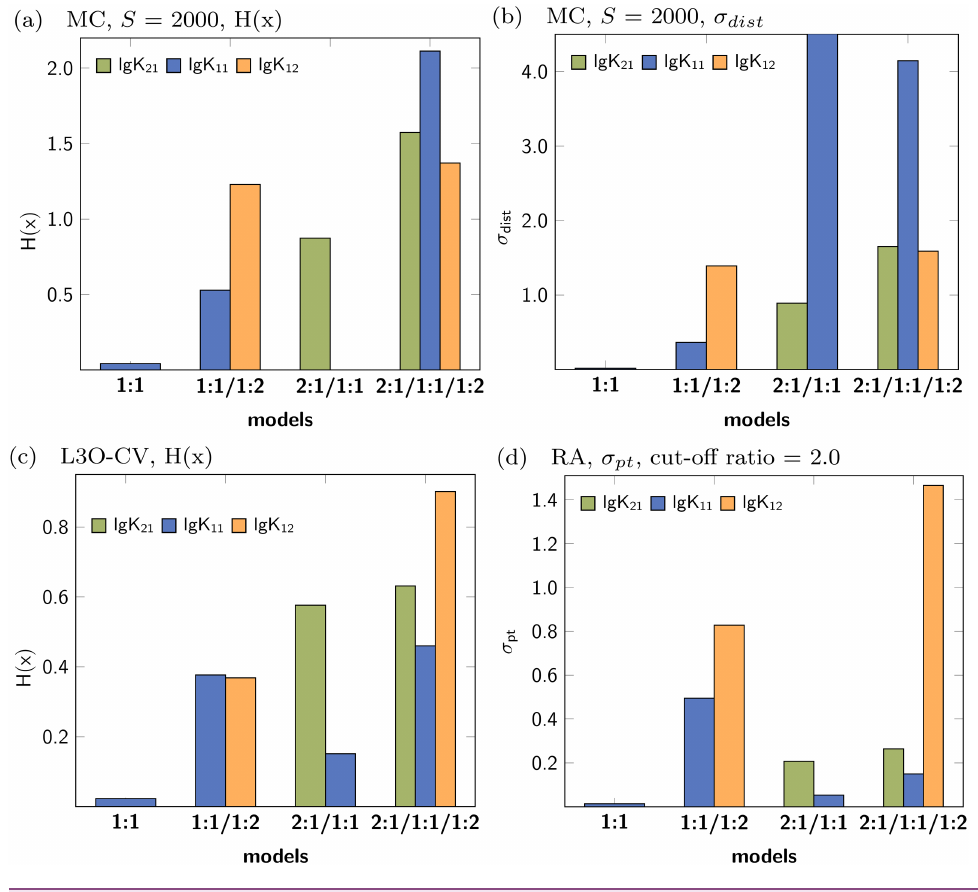
Figure 9 Calculated statistical descriptors for four models (A–D) obtained after Monte Carlo simu- lation, Leave-3-Out Cross Validation and Reduction Analysis performed on a simulated NMR titra- tion with a 1:1 model. Due to the presence of extreme outliers after Monte Carlo simulation on top of the best-fit 2:1/1:1 model , the Shannon entropy could not be calculated for lg K 11 in (A). Full-size DOI: